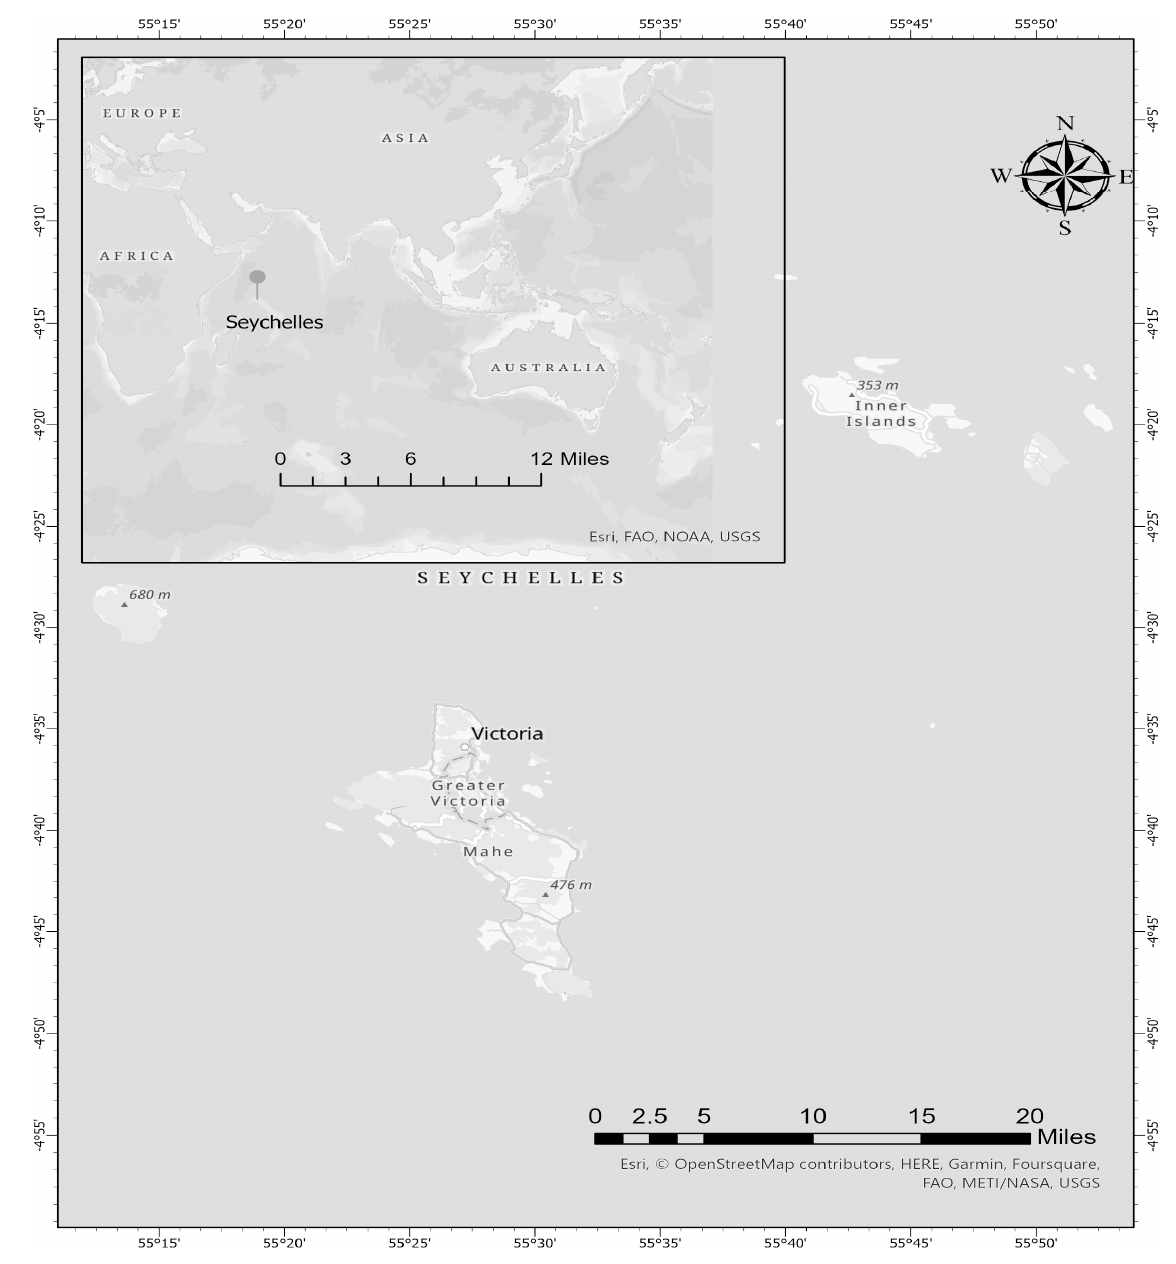
Figure 2. Location of the Seychelles archipelago.